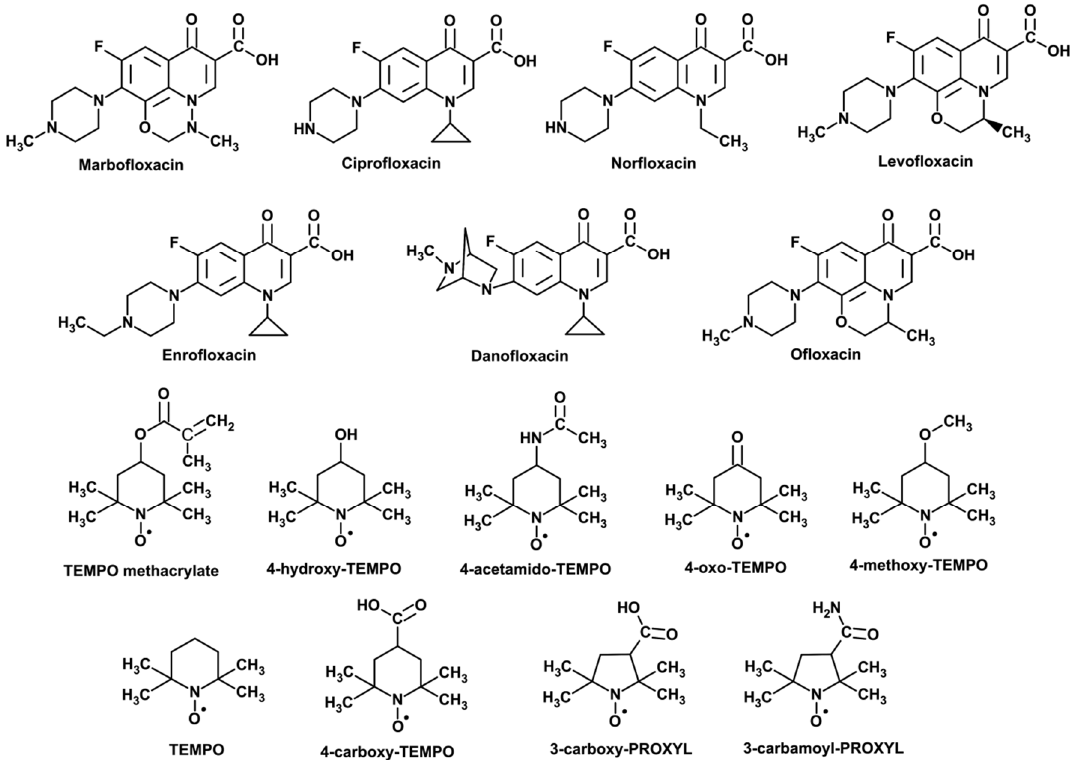
Figure 2. Molecular structures of the selected nitroxide radicals and fluoroquinolone antibiotics (with their commercial names).